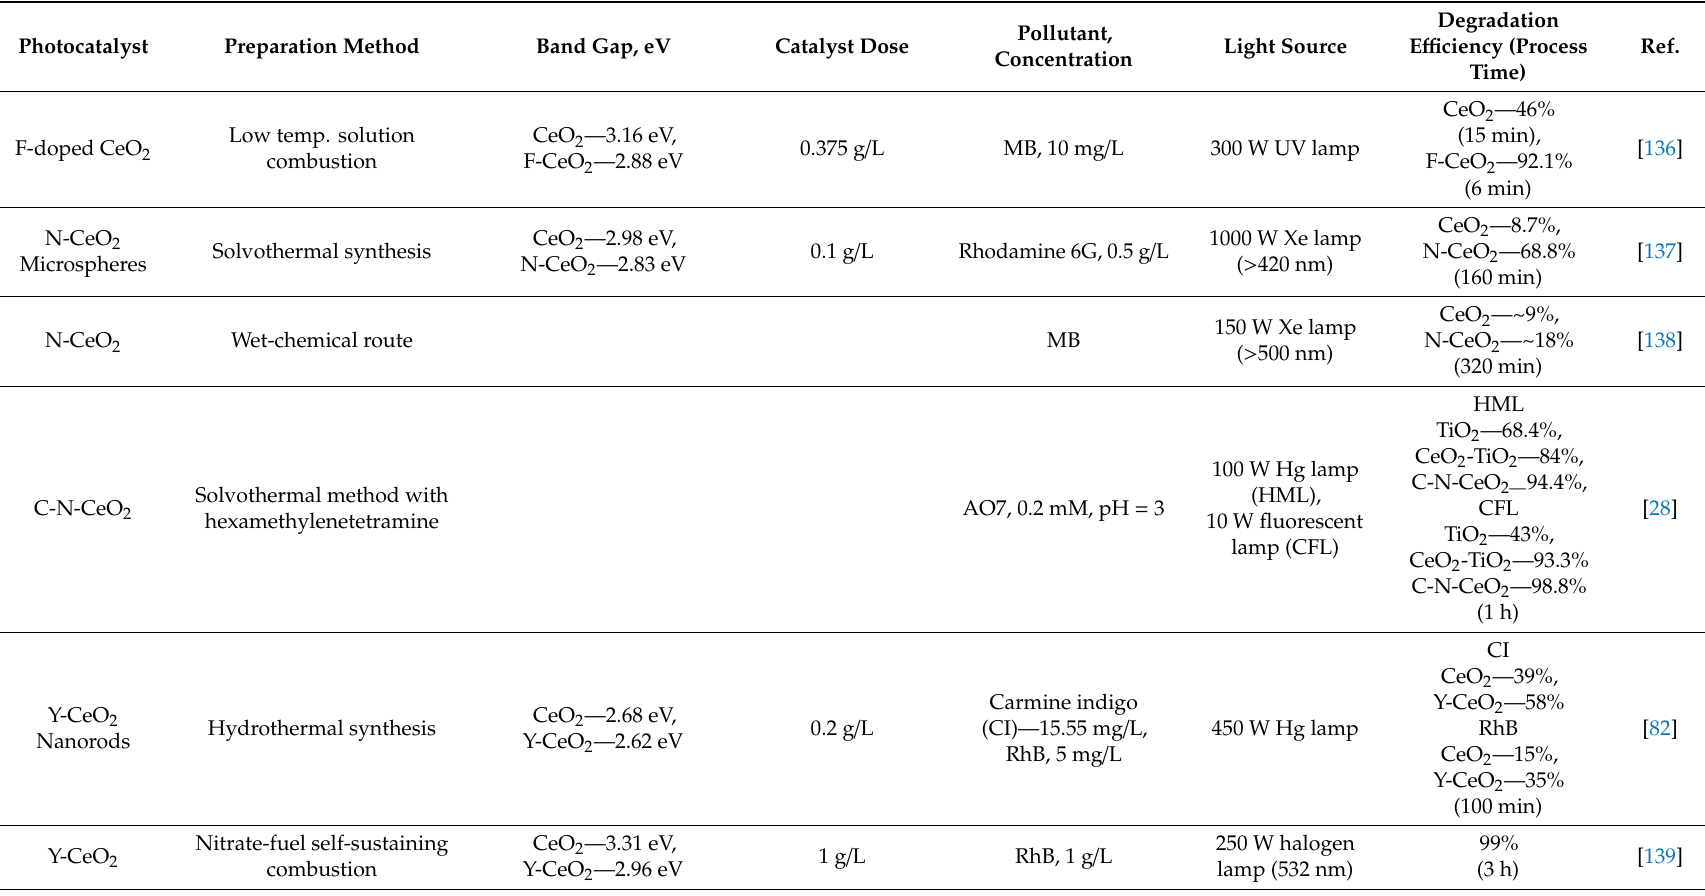
Table 2. Photocatalytic degradation of various pollutants with the application of CeO 2 doped with metals and non-metals as a photocatalytic material.